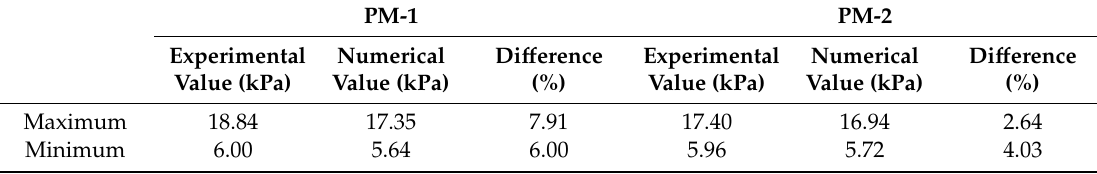
Figure 5. Time history curves of pore water pressure: ( a ) pore-water-pressure measurement (PM)-1 and ( b ) PM-2. Table 4. Maximum and minimum pore water pressures from experimental and numerical results.